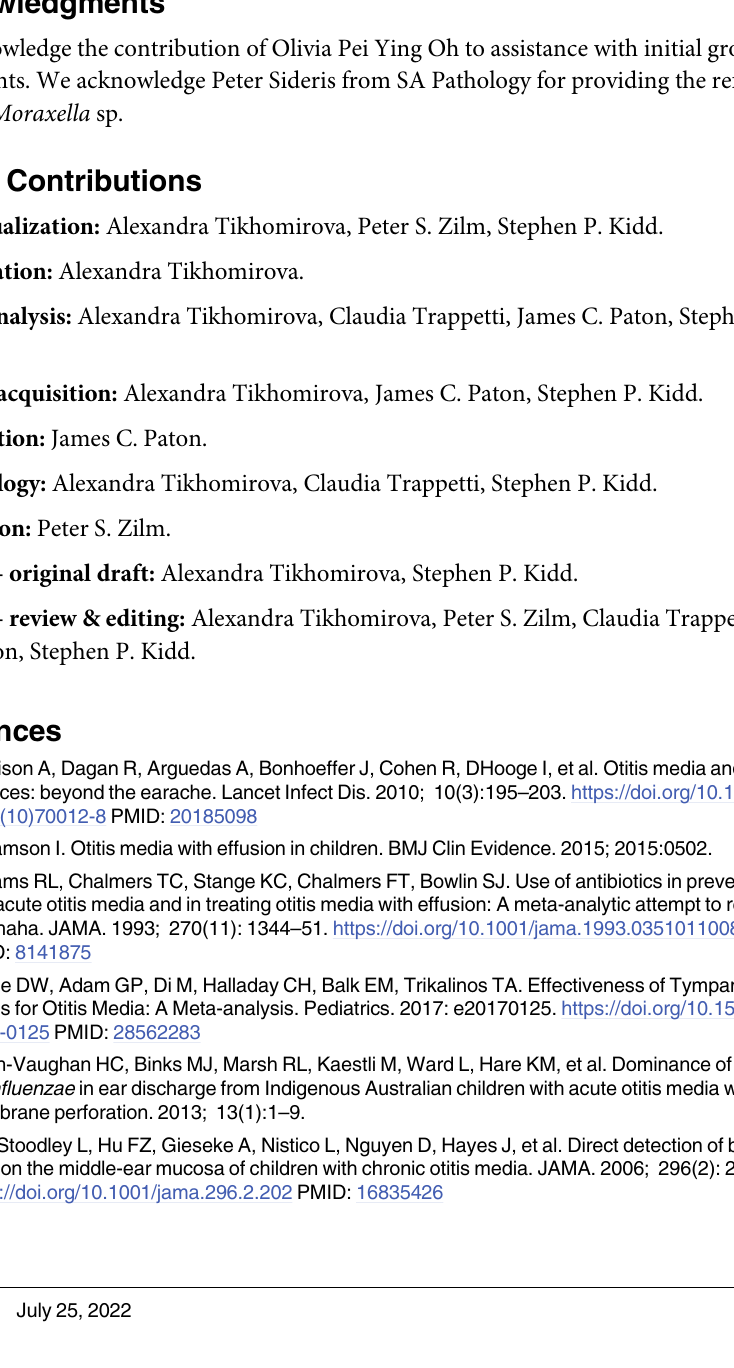
S2 Table. Genes up-regulated in H . influenzae 86-028NP following 2 h growth in triple spe- cies co-culture with S . pneumoniae 11 and M . catarrhalis QC. S3 Table. Genes down-regulated in H . influenzae 86-028NP following 2 h co-culture with